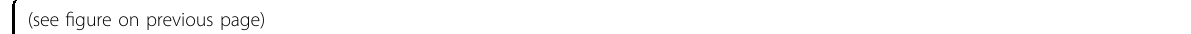
Fig. 2 PTSD-like comorbidities were prevented by PBM early interventions. A – D PBM restores exploratory motor activity de fi cits in the open fi eld arena test. A The apparatus and the representative exploration track for rats. The rectangle with a bold dashed line denotes the center zone. Three weeks post UWT, rats in UWT-group exhibited a signi fi cant reduction of total traveling distance in both the whole arena ( B ) and center zone ( C ), compared with the ctrl-group. PBM treatment restored exploratory activity for both the whole arena and center zone. D During the open fi eld arena test, a higher percent of freezing was observed in UW-group rats but was reversed by PBM treatment. E – H PBM relieves anxiety-like behavior in the elevated plus maze test. E The apparatus for elevated plus maze. Rats in UWT-group spent less time exploring the open arms compared with ctrl- group rats. f PBM treatment increased the time visiting open arms compared to UWT-group rats. g Open arm entries mirrored the trend observed in time spent in open arms. H As a measurement control, all three groups had similar total arm entries. I , J PBM alleviates depression-like behavior in the forced swimming test. I The apparatus for forced swimming test. J PBM decreased the immobile time in PBM-group compared with the other two groups. n = 10, 9, 9 for ctrl, UWT, PBM-group, respectively. K , L A single dose of PBM treatment has no short-term treatment effect on either the elevated plus maze ( K ) and forced swimming test ( L ). To be noted, the anxiety-like, but not the depression-like behavior, was observed at 3 h post UWT. n = 8 each for ctrl-, UWT-, or PBM-group. * P < 0.05 versus UWT-group; # P < 0.05 versus